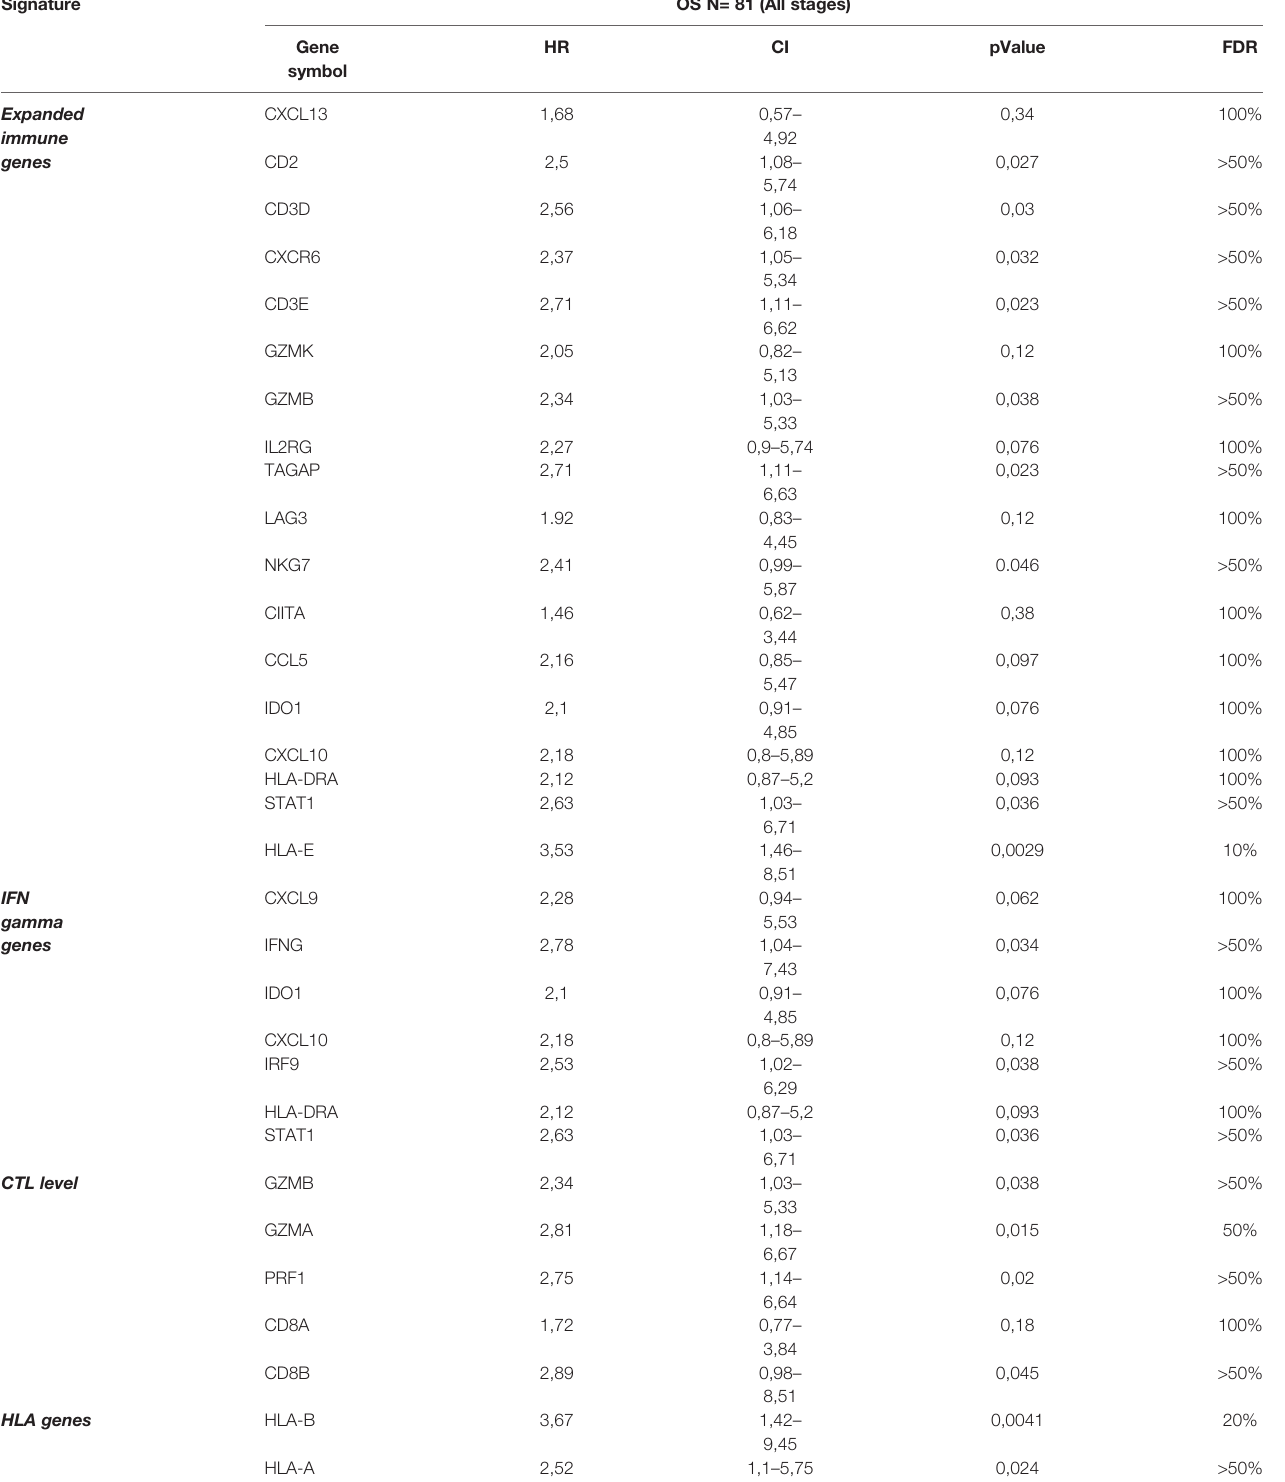
TABLE 4 | Clinical outcome of individual immune genes from the four immune gene signatures in terms of overall survival (OS) of ESCC